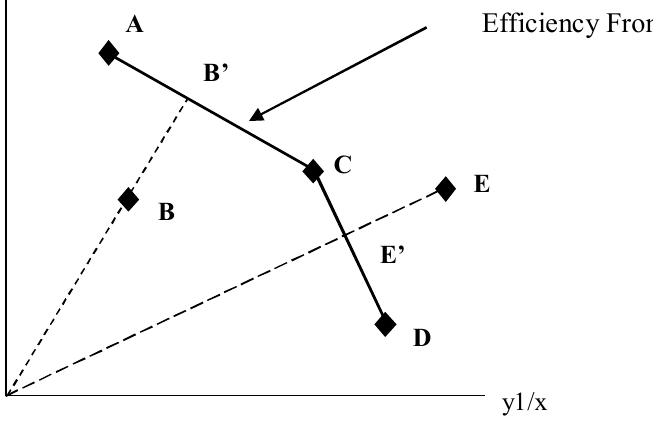
Fig. 1. Efficiency measurement using